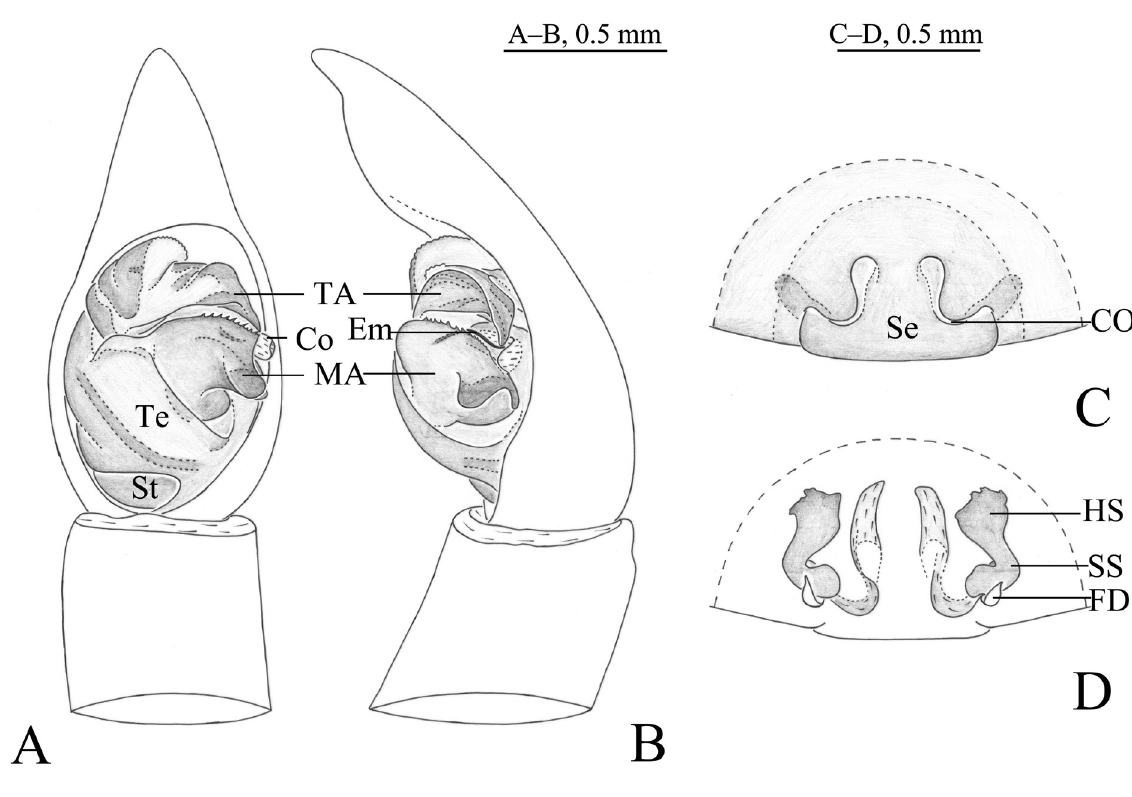
Fig. 2. Serratacosa medogensis gen. et sp. nov. A–B . Holotype, ♂ (SWUC-T-LY-12-01). C–D . Paratype, ♀ (SWUC-T-LY-12-08). A . Left pedipalp, ventral view. B . Left pedipalp, retrolateral view. C . Epigyne, ventral view. D . Vulva, dorsal